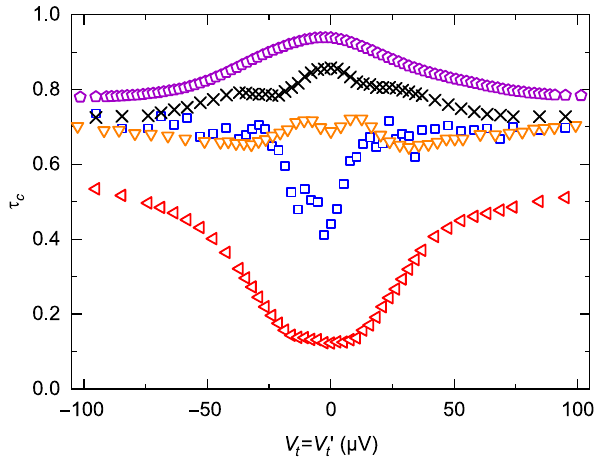
FIG. 12. Analyzer QPC transmission τ versus direct voltage c c V bias V at ν ¼ 1 = 3 . Different symbols correspond to t ¼ t 0 different tunings of QPC . An identical device tuning to Fig. 3 c is represented here by the same